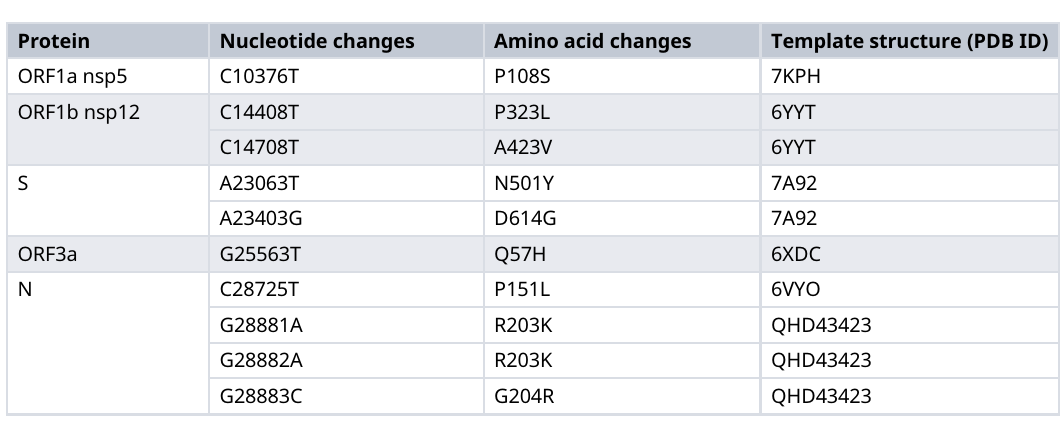
Table 1. SARS-CoV-2 protein structures used in this